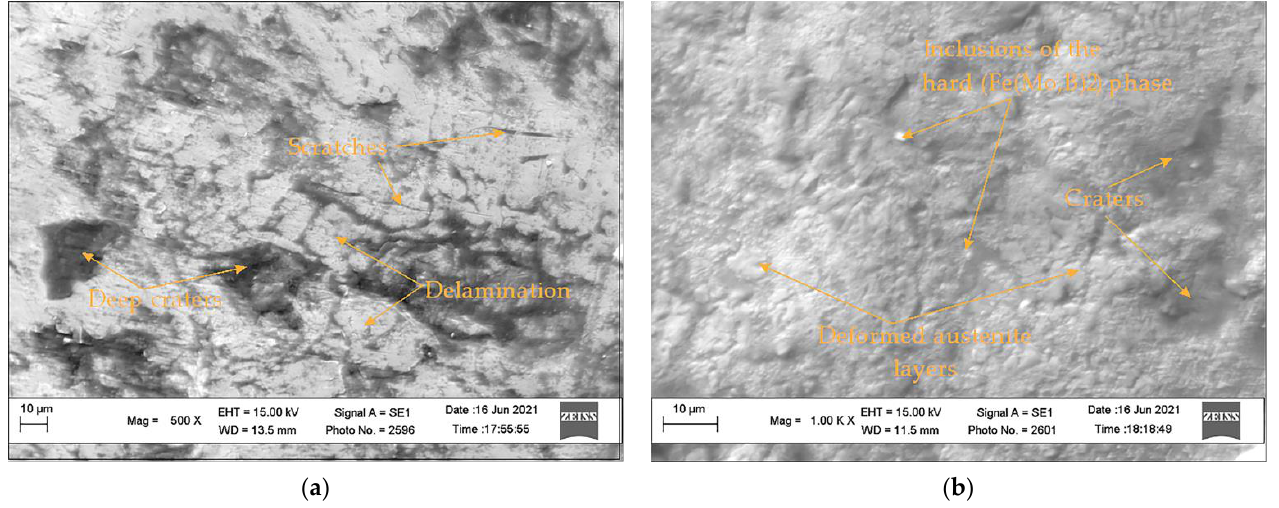
Figure 12. The SEM micrographs of the worn surfaces after impact-abrasion wear tests: ( a ) HSS sample; ( b ) Sample 3.